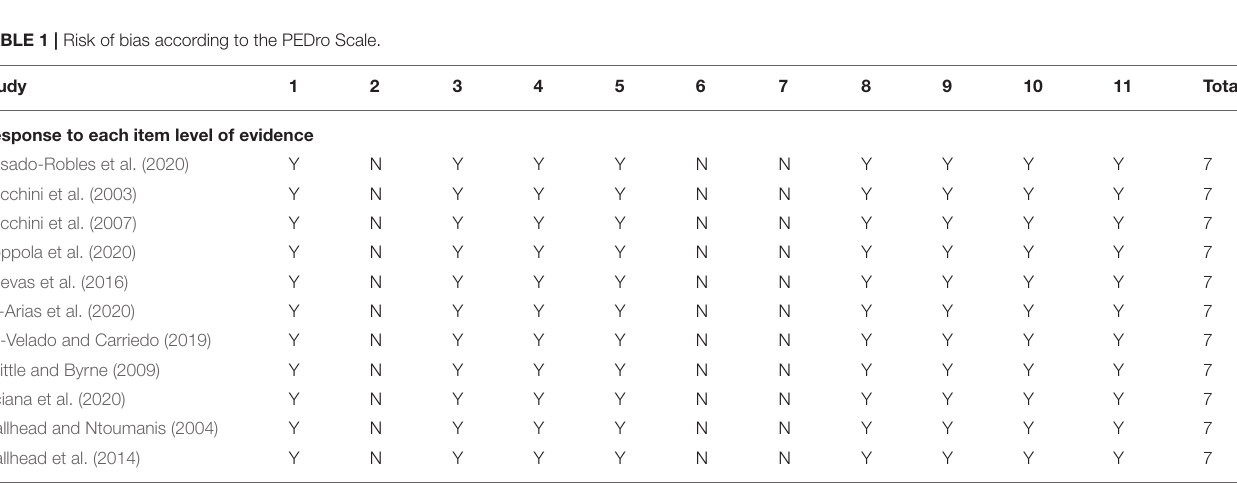
FIGURE 1 | Flowchart of the systematic review process according to the PRISMA protocols declarations.